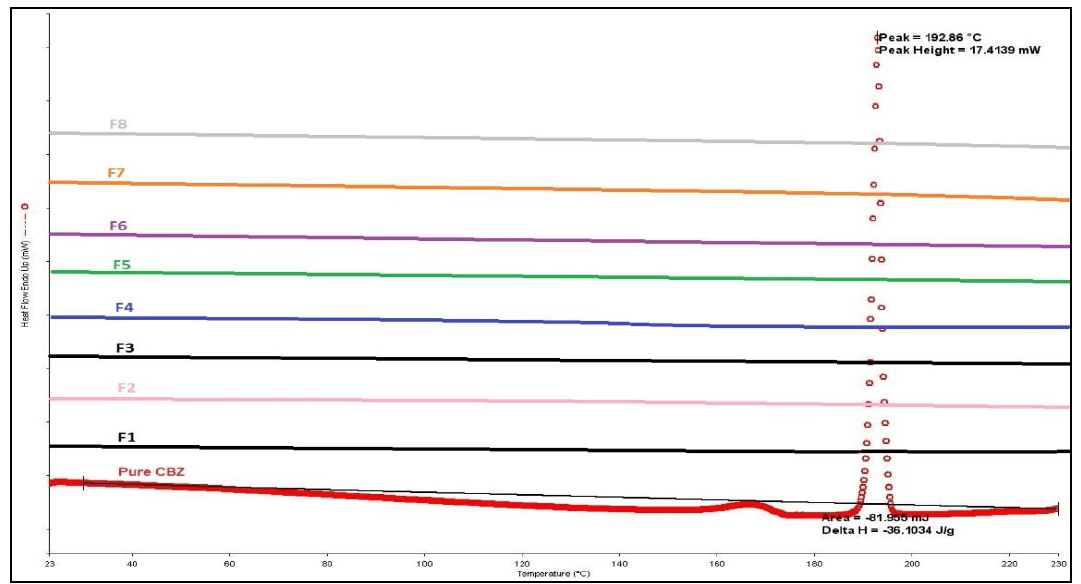
Figure 4. DSC data for pure CBZ and di ff erent formulations (F1–F8) (15:85; CBZ: Soluplus ® ).